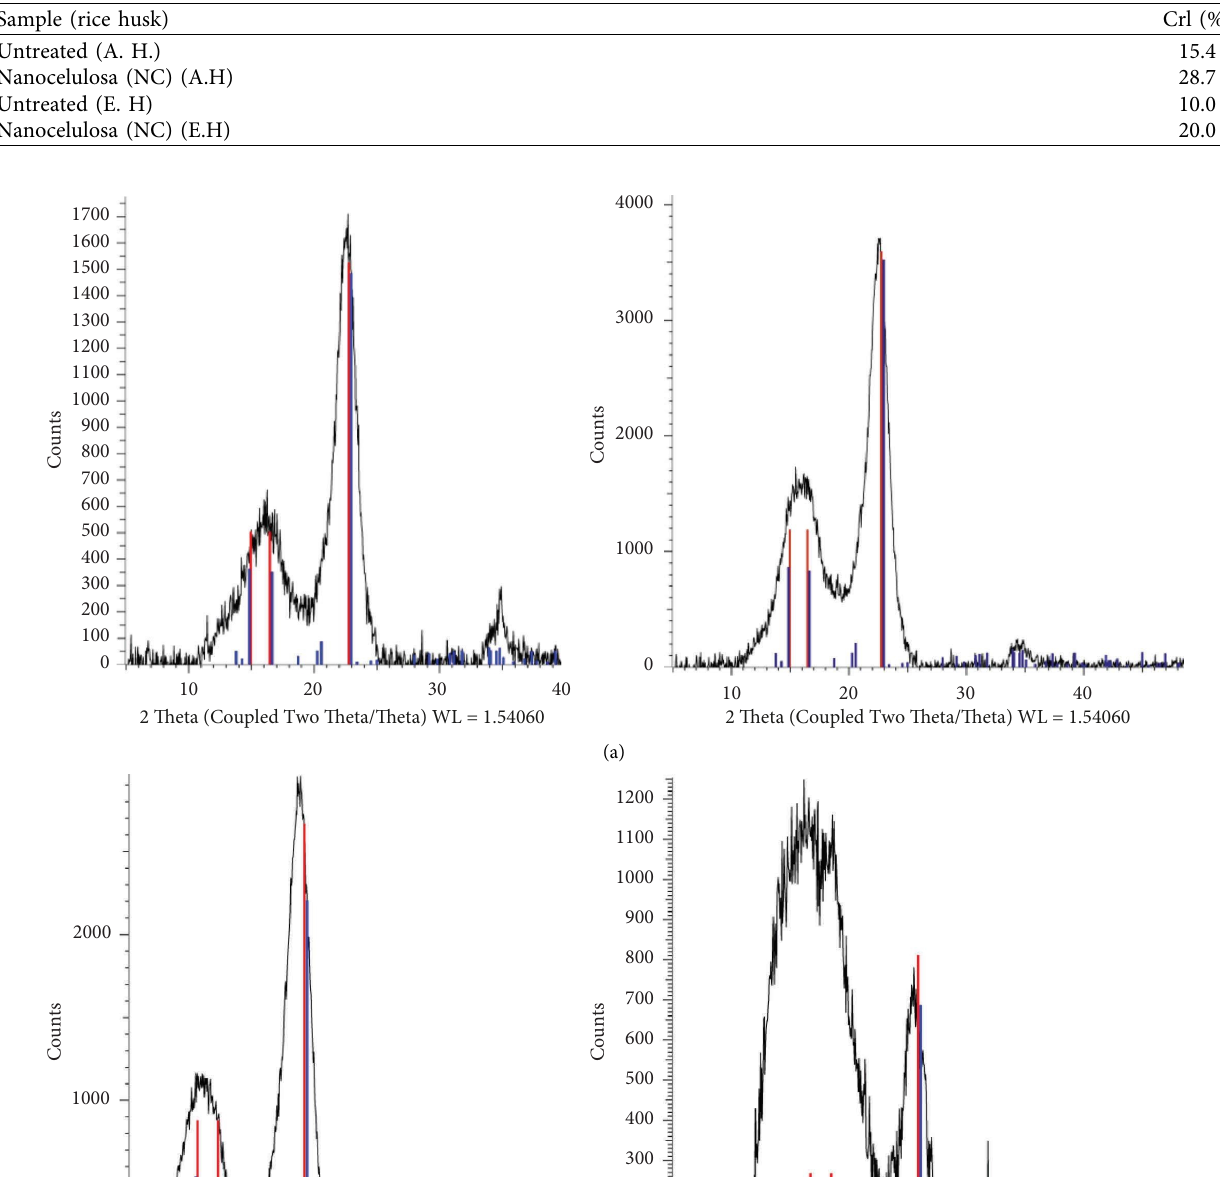
Table 1: Comparative summary of crystallinity index (CrI %) calculated, following Segal’s method [4], for rice husk fbers at diferent stages, cellulose untreated and after used both hydrolysis.